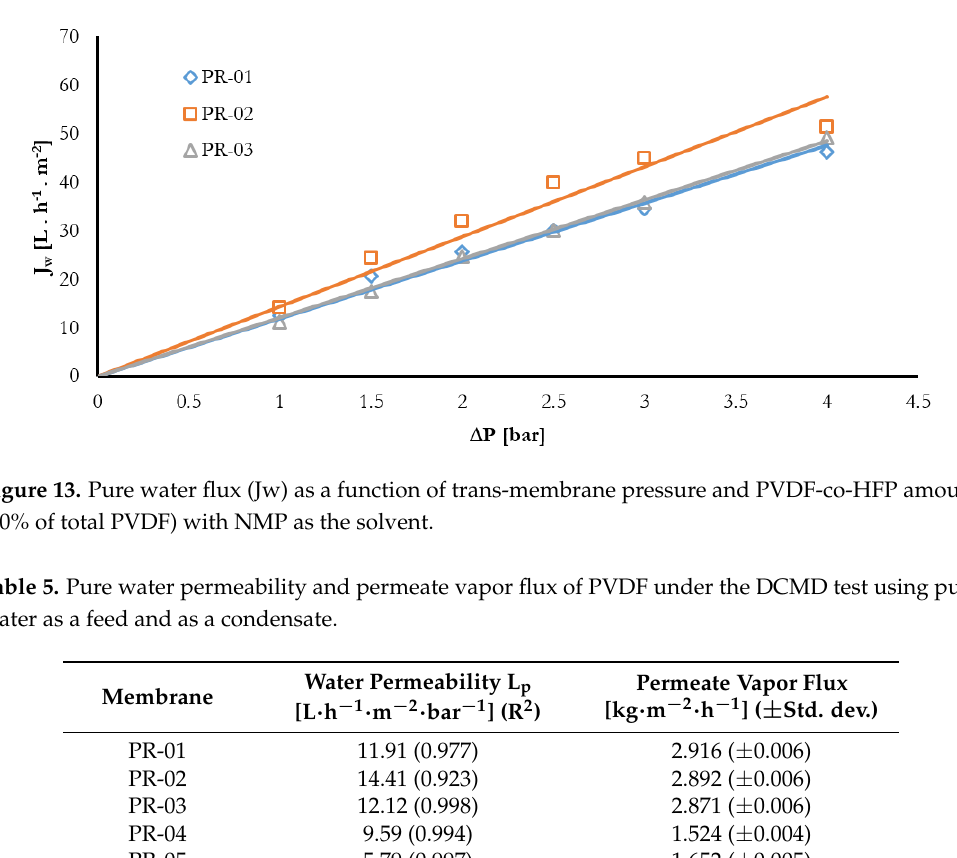
Table 5. Pure water permeability and permeate vapor flux of PVDF under the DCMD test using pure water as a feed and as a condensate.